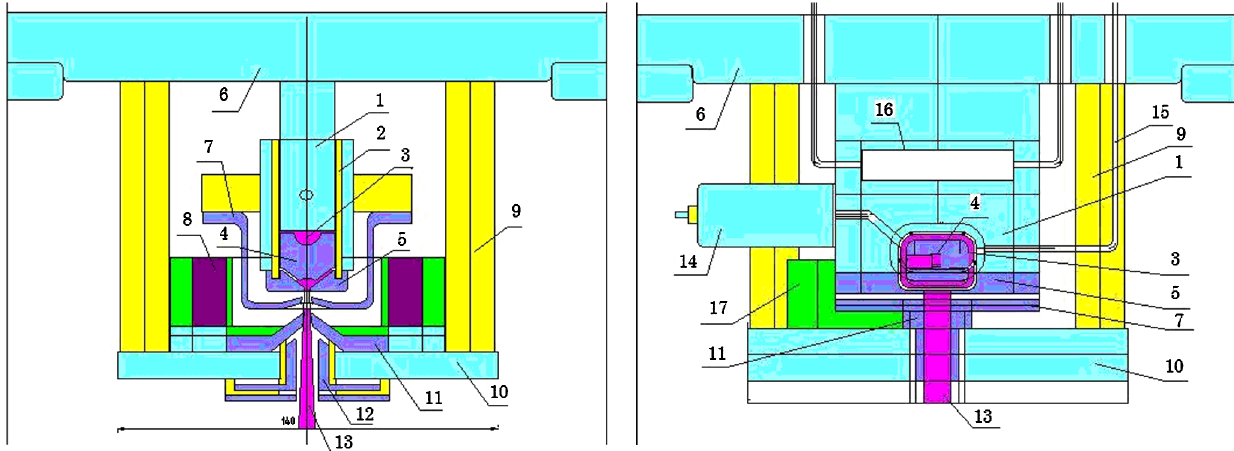
FIG. 2. Schematic of upgraded magnetron (planotron) SPS. Left: Cross section along the magnetic field. Right: Cross section perpendicular to the magnetic field. (1) Cooled anode; (2) high thermoconductive insulator ALN; (3) discharge gap; (4) cathode with channel for HCD; (5) plasma plate with emission aperture; (6) cooled high voltage flange; (7) first extractor-electron collector; (8) permanent magnet with magnetic poles and yoke; (9) high voltage insulators; (10) baseplate; (11) grounded extractor; (12) suppressor of positive ions; (13) ion beam; (14) gas valve; (15) cesium delivery system; (16) cooling channel; (17) magnetic yoke.